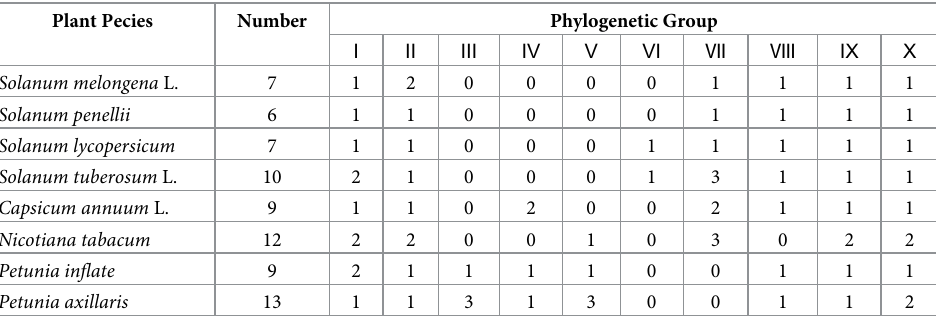
Table 3. Distribution of CHS genes in the phylogenetic tree. Plant